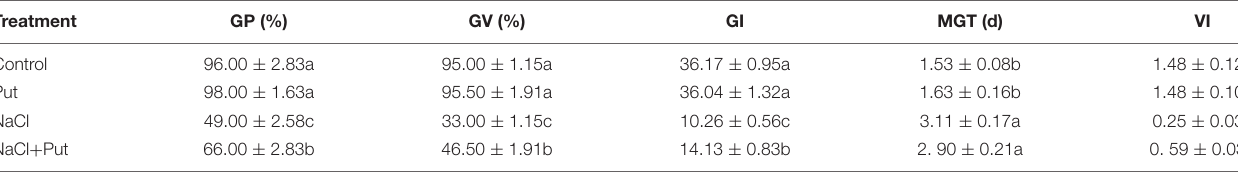
TABLE 2 | Effects of seed priming with water or putrescine (Put) on seed germination characteristics.